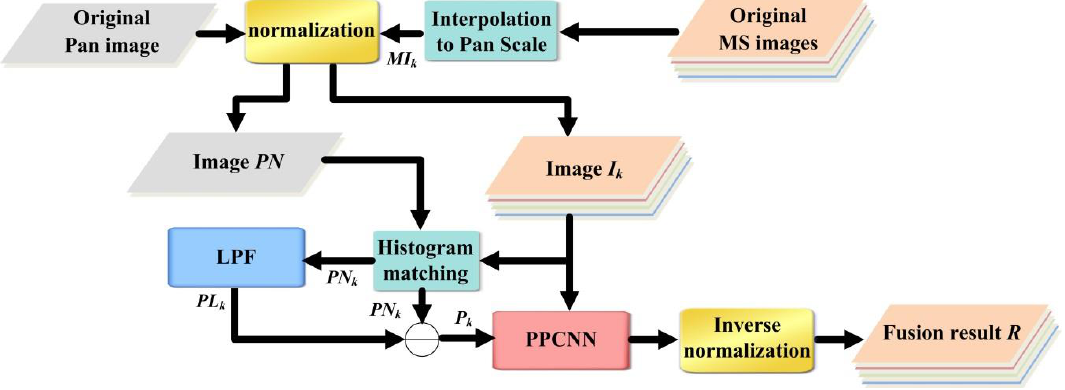
Figure 6. Procedure of PPCNN pansharpening approach.